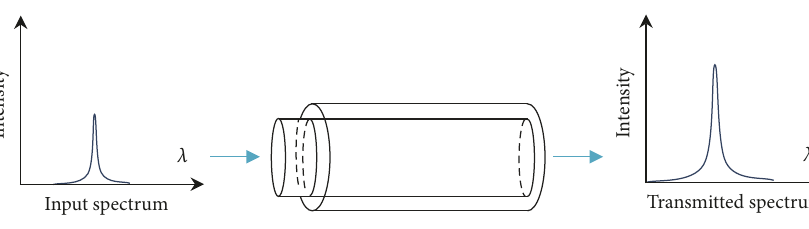
Figure 2: Erbium Doped Fiber